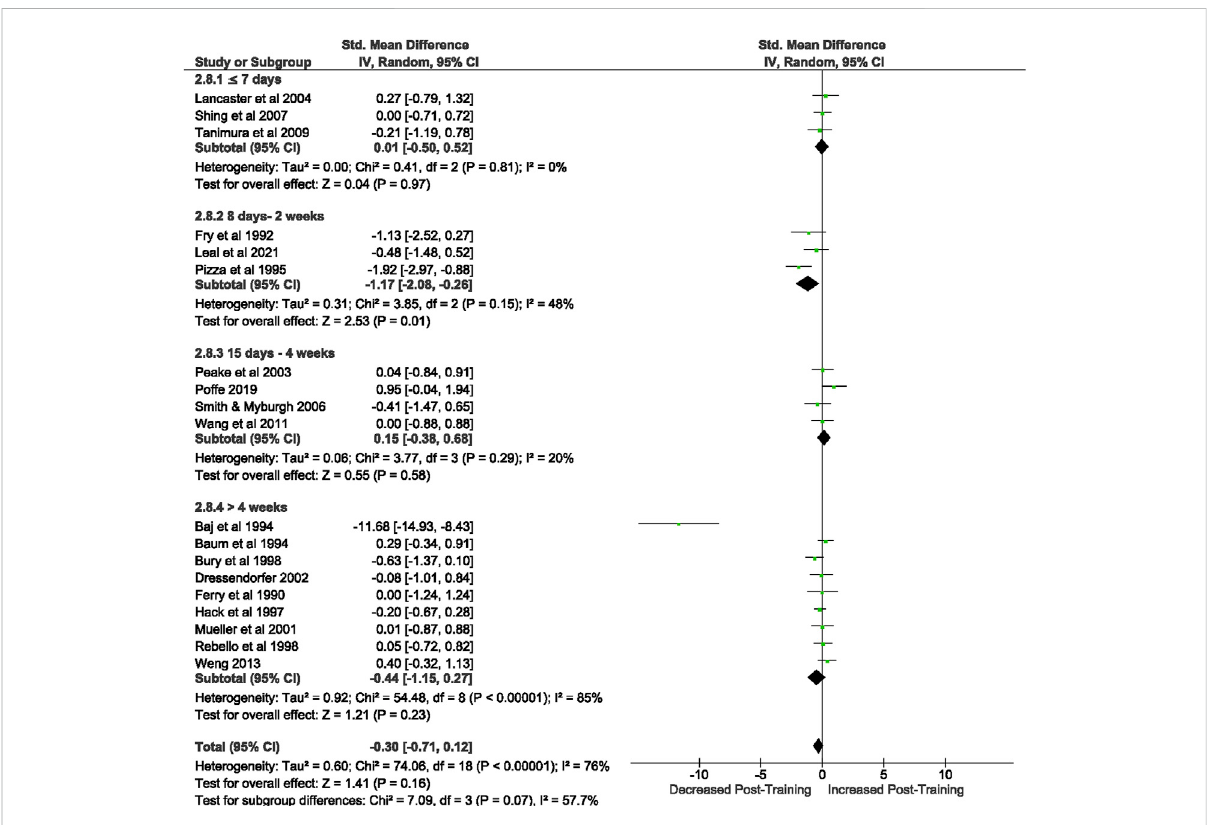
FIGURE 4 Effect of intensi fi ed training on resting CD4+ T cell counts, measured by FACS or Automated cell counter. Subgroup analysis is based on the duration of intensi fi ed training period; ≤ 7 days, 8 days — 2 weeks, 15 day — 4 weeks and > 4 weeks. All studies used human participants. CI Con fi dence